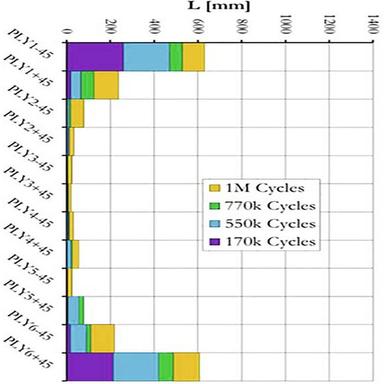
Ex situ segmentation results for a woven specimen tested at 250 °C.